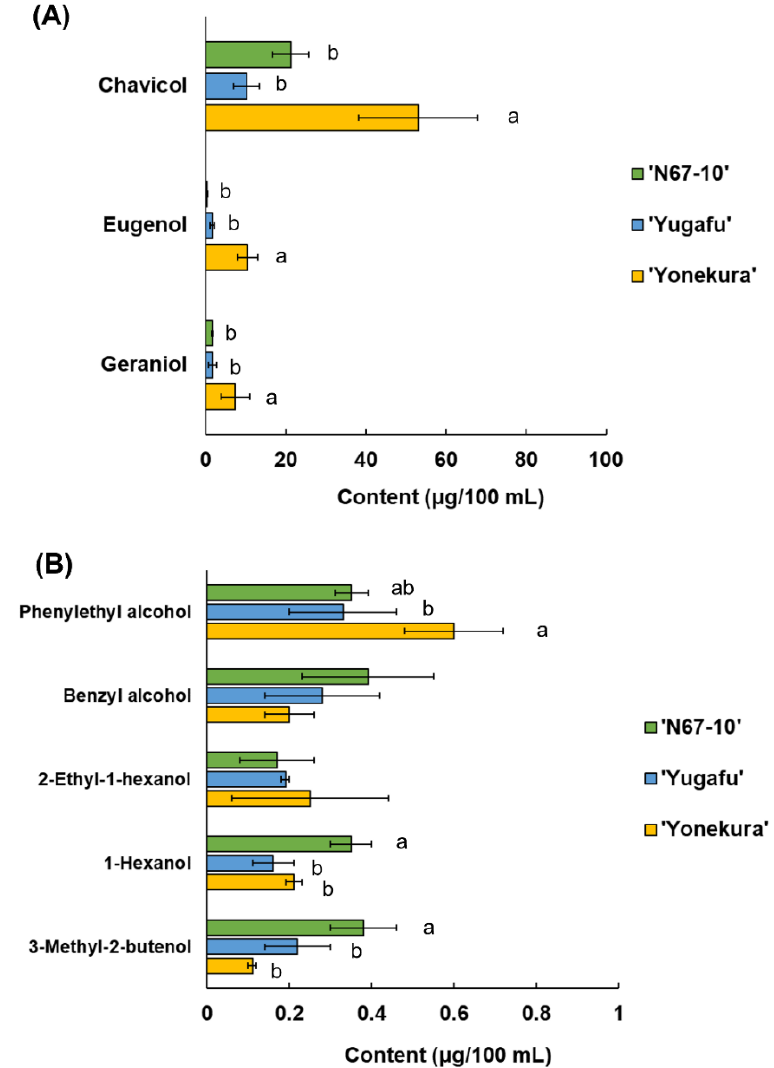
Figure 2. Released volatile compounds from glycosides of Okinawan pineapple: ( A ) Major compo- nents (content is more than 1 µg/100 mL); ( B ) minor components (content is less than 1 µg/100 mL). Each value is expressed as the mean ± standard deviation of three replicates. Means in the same group followed by the same letter are not significantly different at p < 0.05.